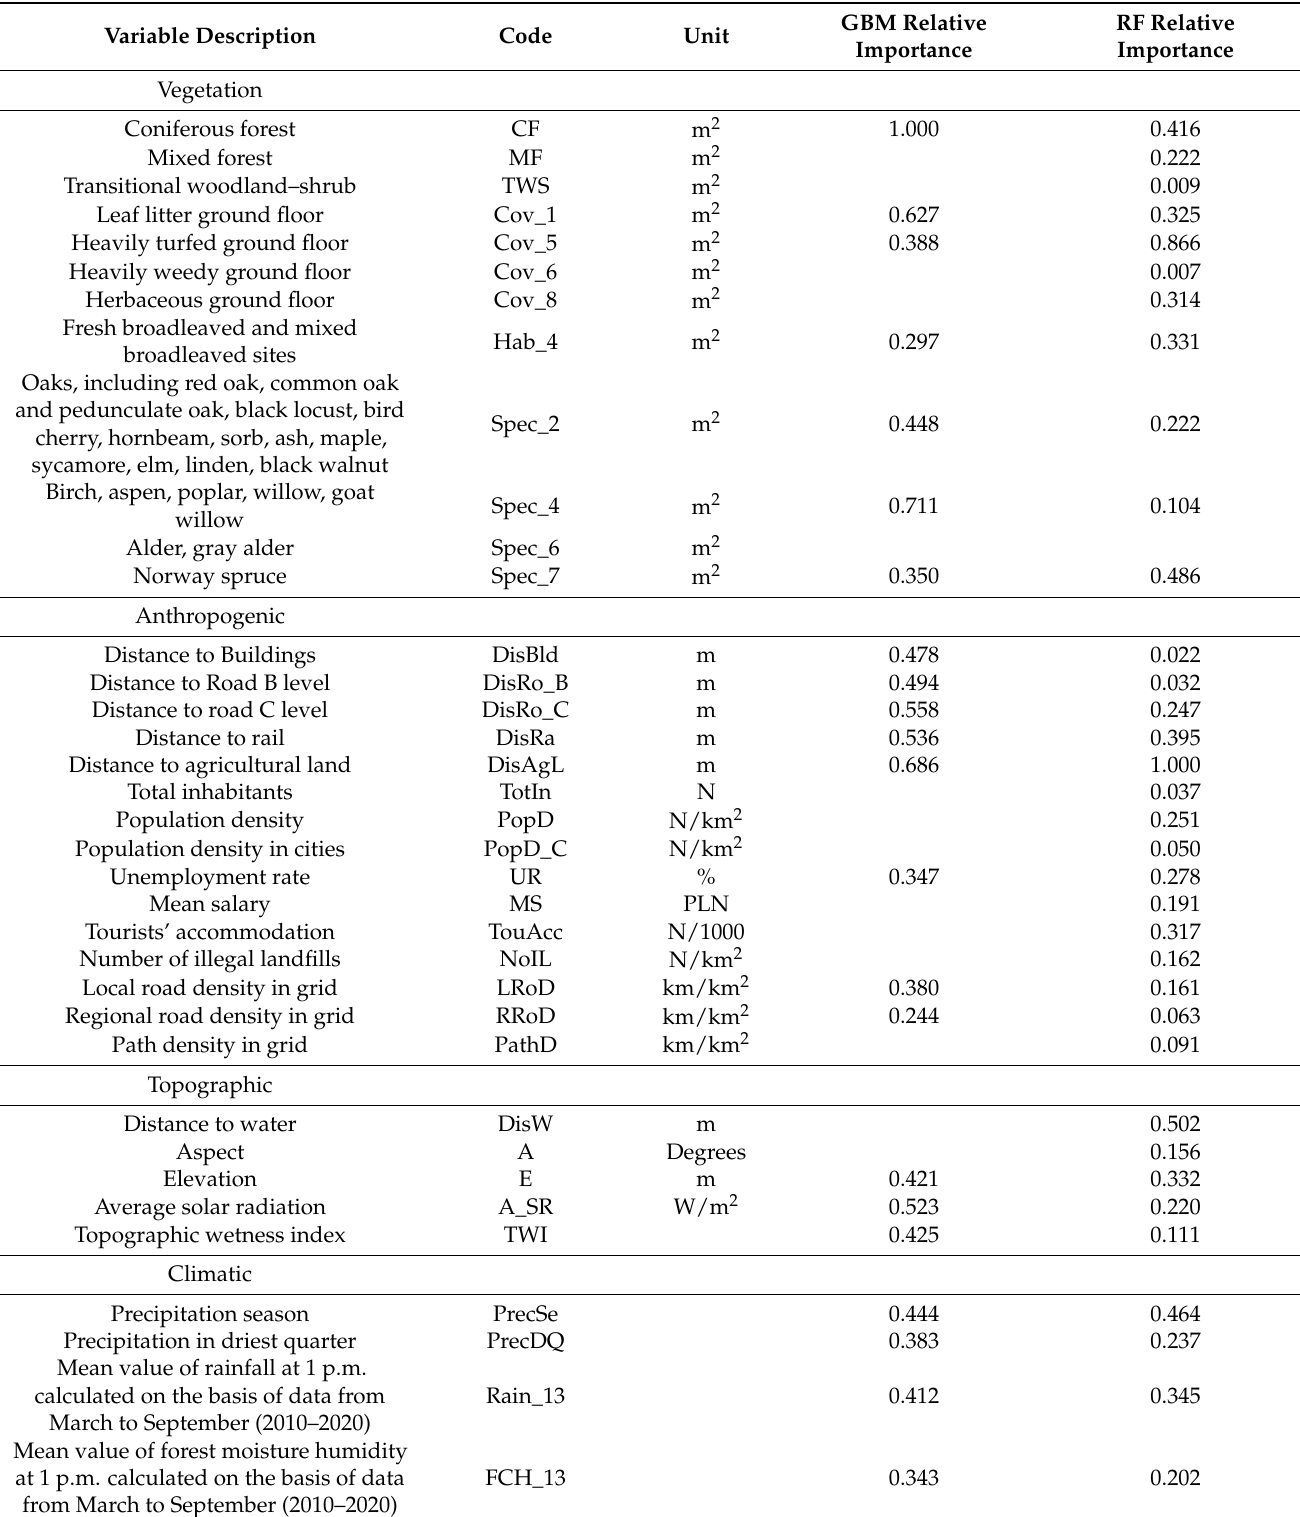
Table 1. Explanatory variable importance evaluation based on Gini impurity for RF and GBM